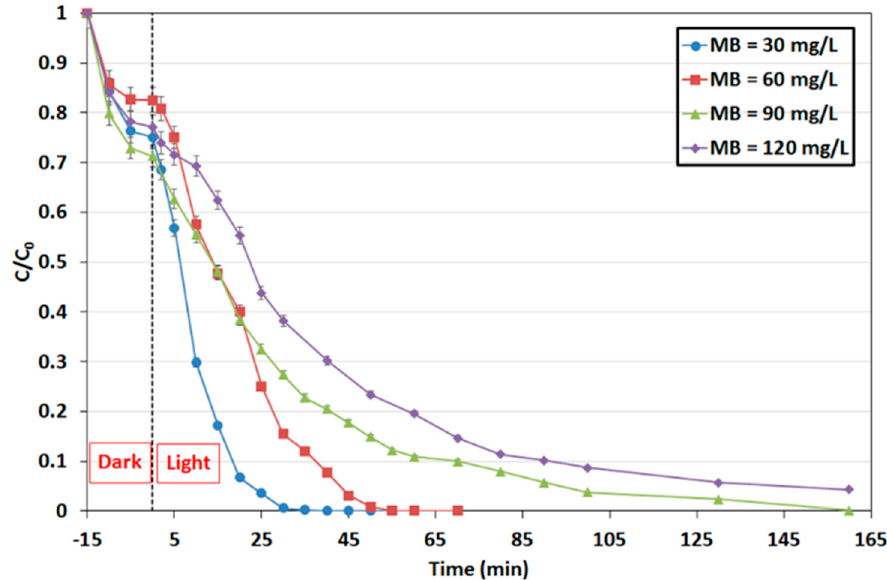
Figure 4. Influence of the MB concentration of the catalytic activity of the TiO 2 photocatalyst (pH neutral; DTiO 2 = 1 g/L; temperature = 20 ± 2 °C).